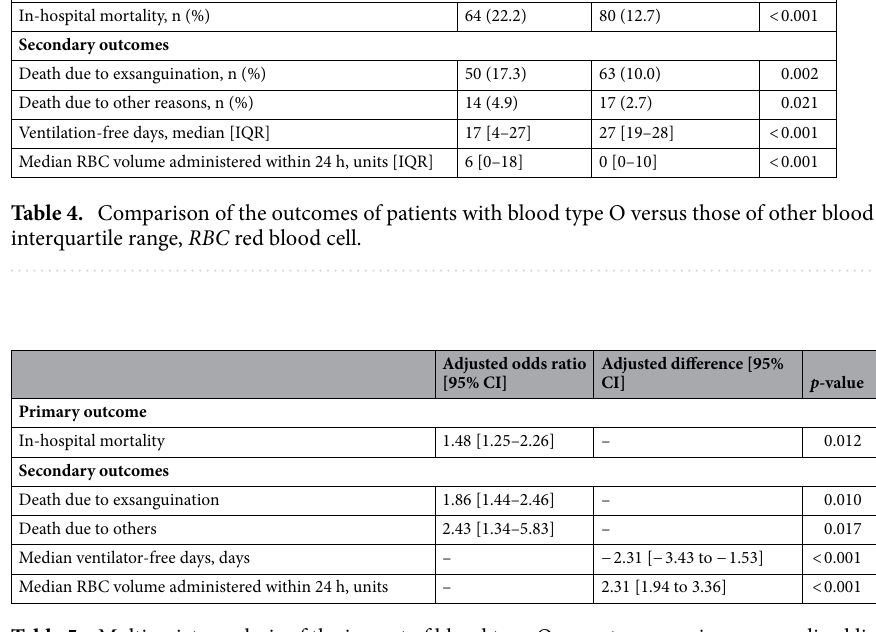
Table 5. Multivariate analysis of the impact of blood type O on outcomes using a generalized linear mixed model. CI confidence interval, RBC red blood